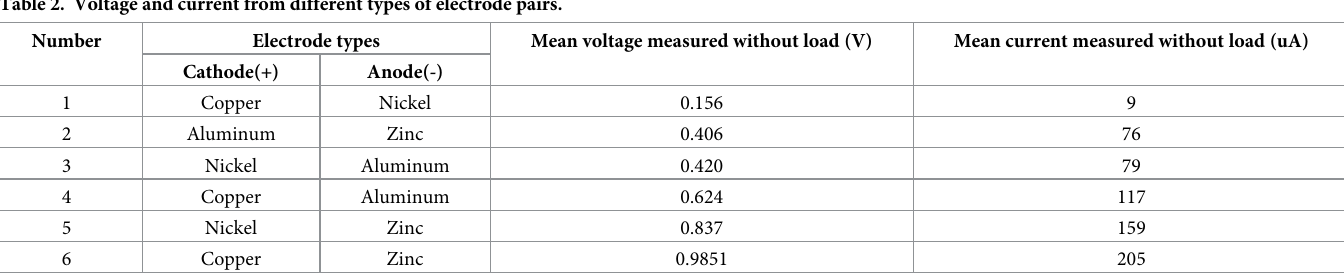
Table 2. Voltage and current from different types of electrode